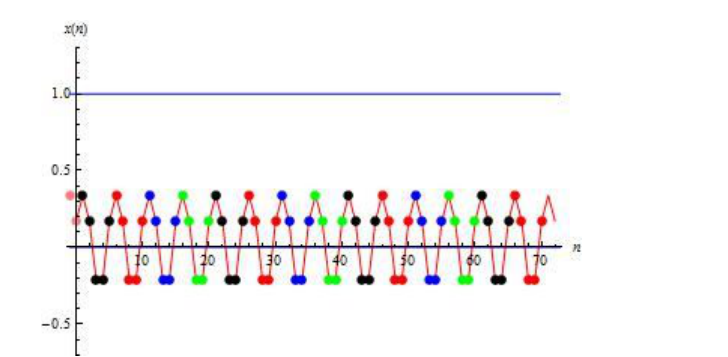
Figure 11. Period 5 for α = 0.5, t( − 1) = 0.3387353751757066‘, t(0) = 0.1707400845904967‘ (see Table 1).